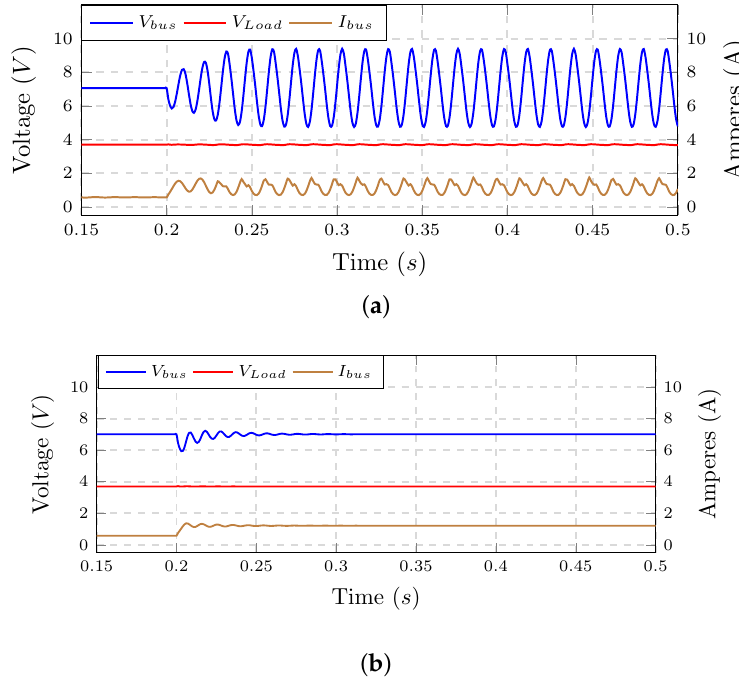
Figure 22. The dynamic performance of the boost-driven cascaded system: ( a ) without the proposed controller; and ( b ) with the proposed controller.